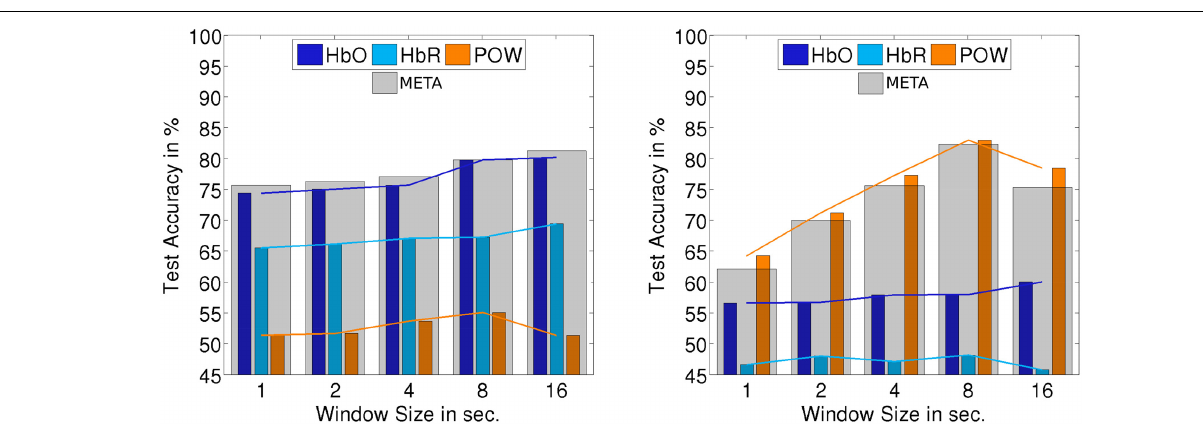
FIGURE 11 | Accuracy for subject-independent classification of allAUD vs. nonAUD (left) and allVIS vs. nonVIS (right) on continuous data. Results are in dependency of window size.